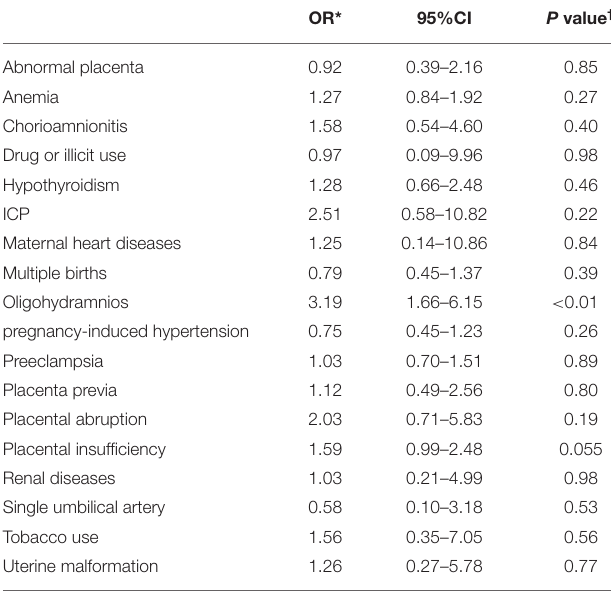
TABLE 5 | Binary logistic analysis for the associations between maternal complications and gestational diabetes mellitus among SGA infants ( N =